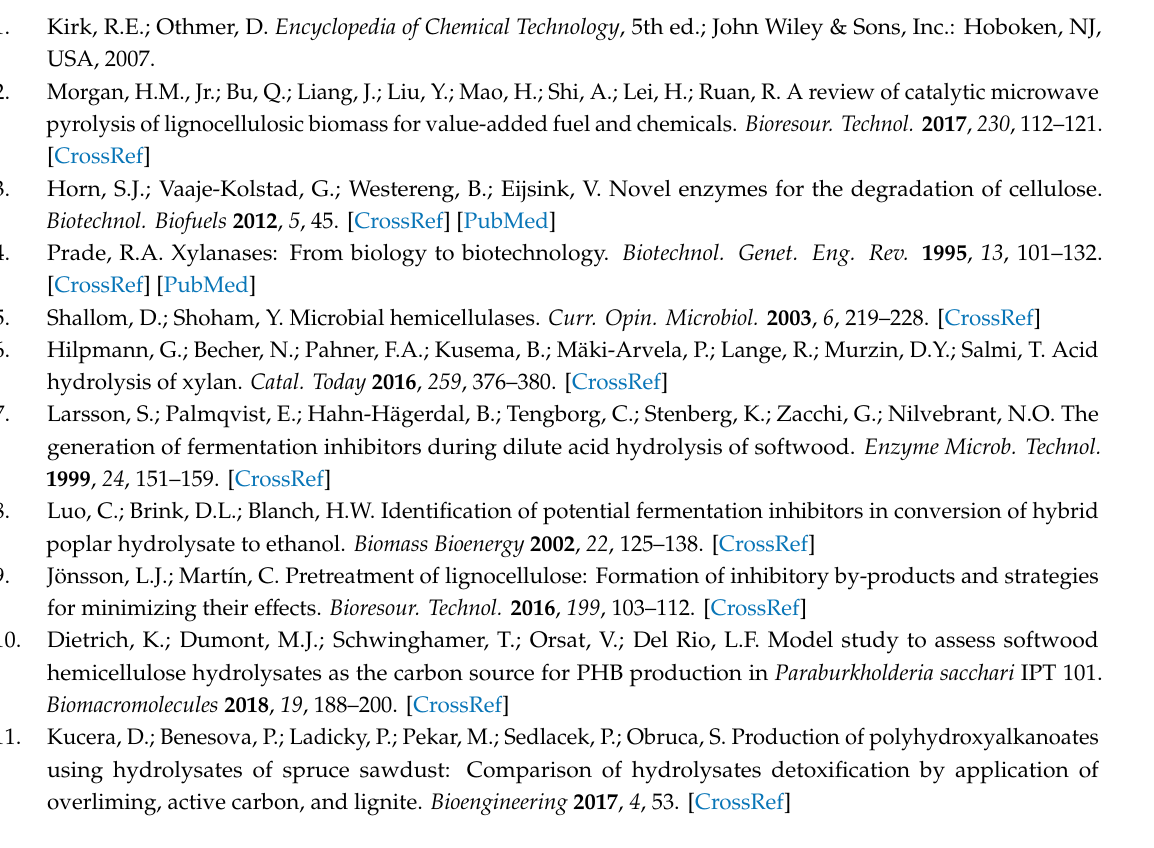
Figure S1: SDS-PAGE analysis (0.1% SDS (w / v), 25 mM Tris) of commercial xylanase from Thermomycec lanuginosus., Figure S2: Optimization of the amount of water (reported as η , i.e., the volume of water added over the total amount of solid in µ L / mg) for the hydrolysis of purified birchwood (A) or oat spelt (B) xylan by xylanase under milling conditions., Figure S3: Optimization of the amount of water (reported as η , i.e., the volume of water added over the total amount of solid in µ L / mg) for the hydrolysis of sugarcane bagasse (A) or wheat straw (B)., Figure S4: Optimization of the enzyme loading for the hydrolysis of birchwood xylan, oat spelt xylan, sugarcane bagasse or wheat straw by xylanase under milling only (30 min) or milling (30 min) followed by aging (72 h at 55 ◦ C)., Figure S5: E ff ect of milling frequency (10 Hz or 30 Hz) on the xylanase-catalyzed hydrolysis of oat spelt xylan. Table S1: Results of sugar